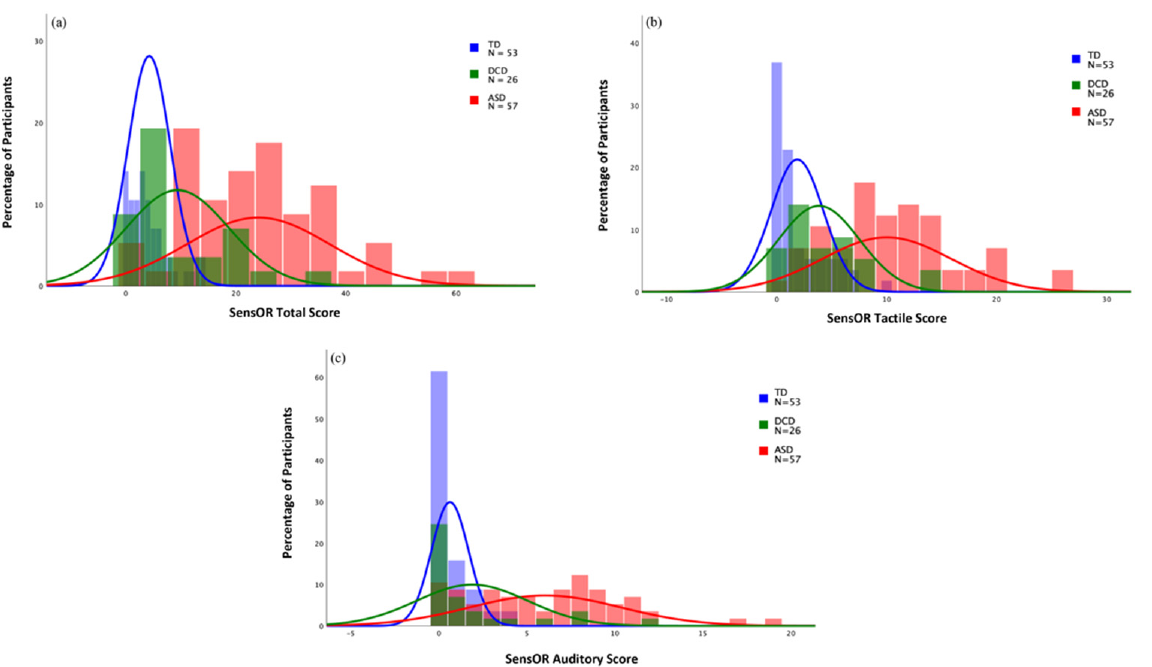
Figure 1. Histograms for SensOR total score and subscores. ( a ) SensOR total score; ( b ) SensOR tactile score; ( c ) SensOR auditory score.